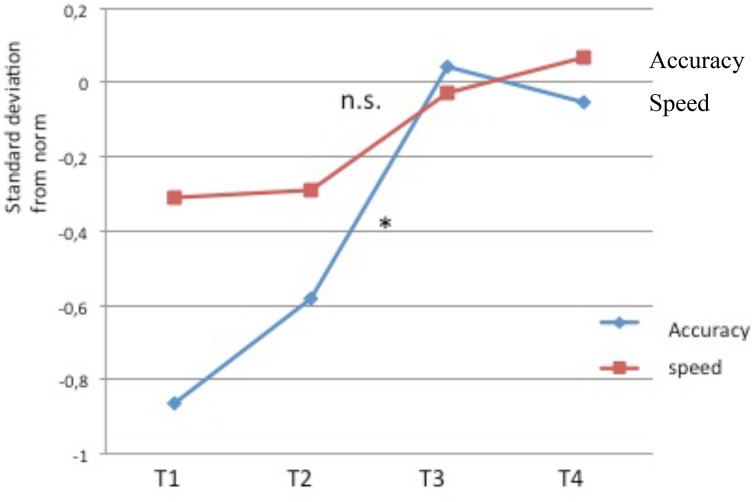
Phonemic fusion task (in standard-deviations from age norm). Evolution of the level of performance across time. Significant improvements are found for accuracy (*p < 0.05) but not for speed (ns: non significant).